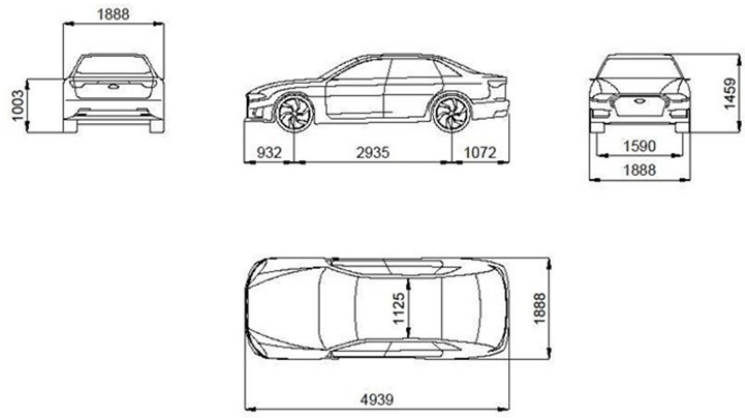
Figure 7. Final sketches of the proposed car style combining the four possibilities.